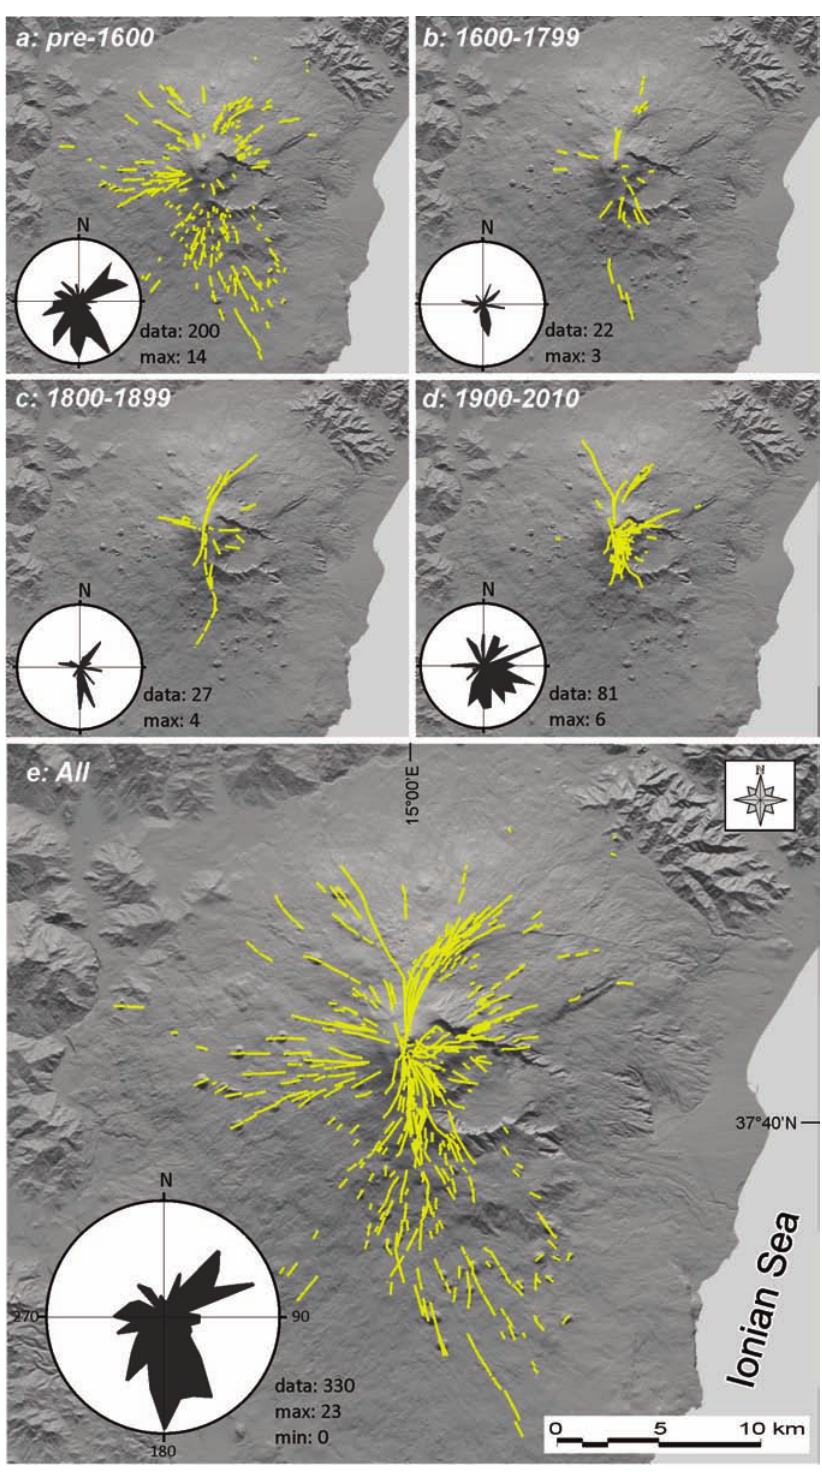
Figure 5. Historically active eruption fissures at Etna, grouped into periods: pre-1600 (a), 17 th and 18 th centuries (b), 19 th century (c), 1900-2010 (d), and all of the fissures together